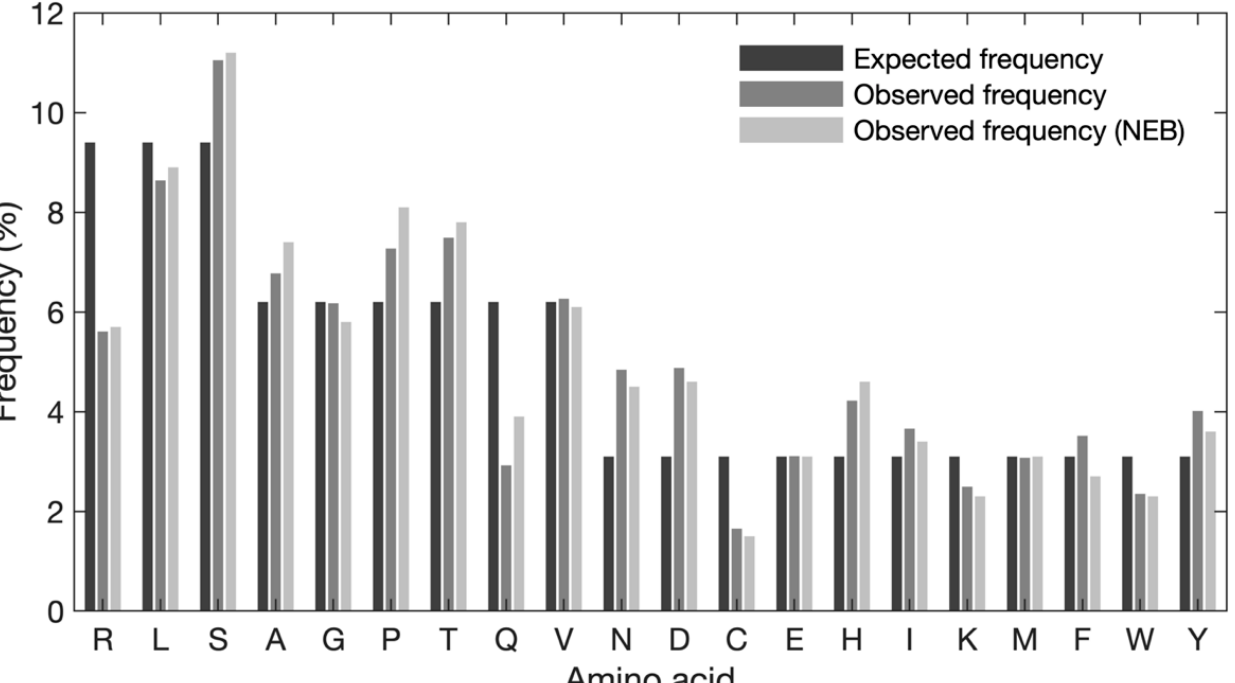
Figure 3. Global frequency of each amino acid (one-letter code). The expected frequency calculated based on available codons is compared to the observed frequency from our dataset and to the observed frequency provided by NEB. The frequency of glutamine (Q) does not include those encoded by the TAG codon. The frequency of unaccounted Q is 0.4 percentage points.